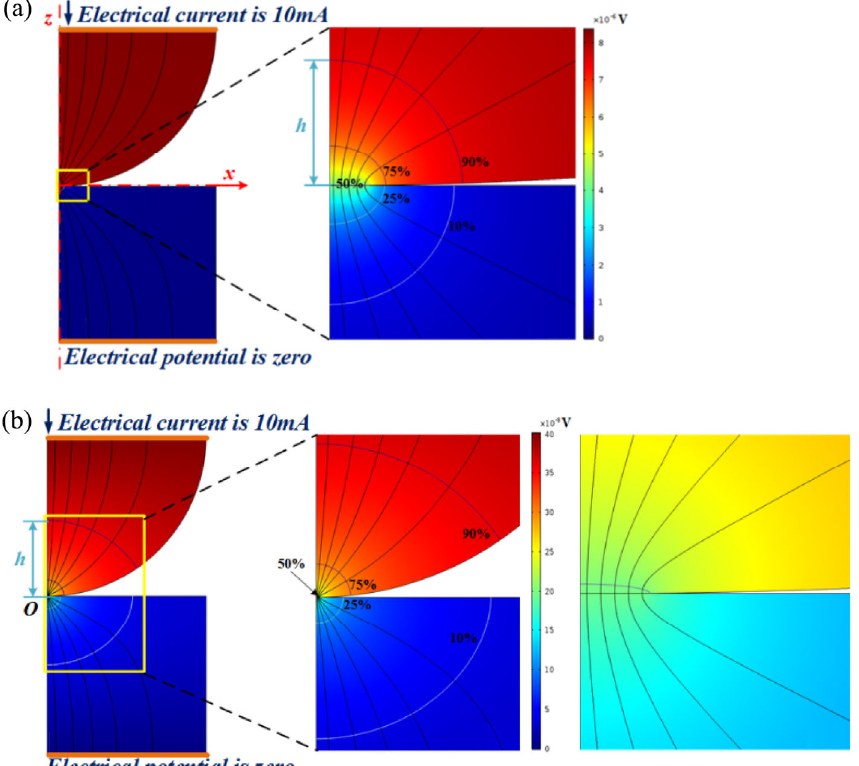
Fig. 72 Distributions of electrical current lines and isopotential. (a) Sphere–plane contact and (b) cylinder–plane contact [910]. Reproduced with permission from Ref. [910], © IEEE,